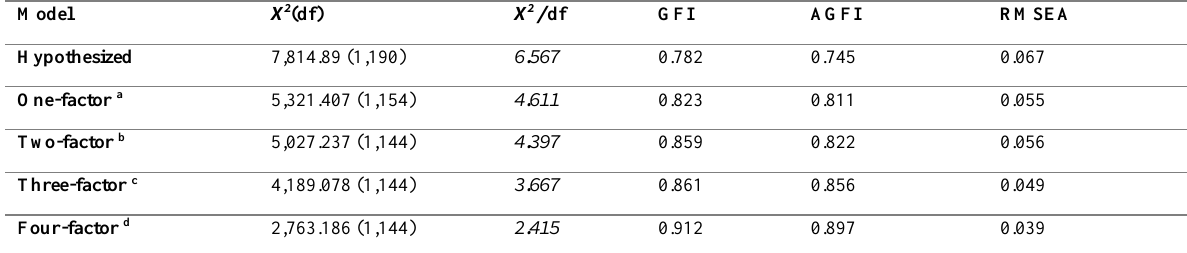
Table 2: Confirmatory Factor